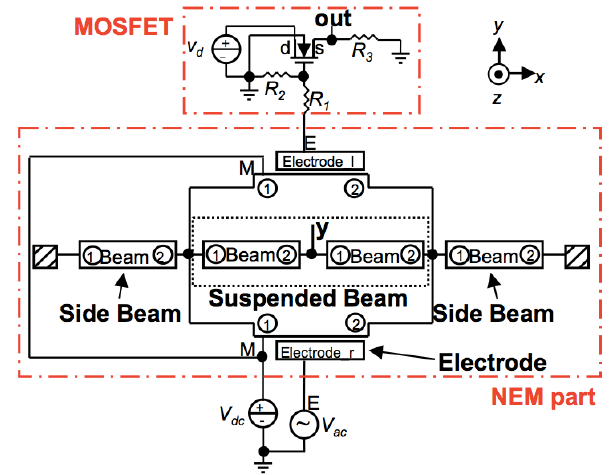
The hybrid circuit model of the in-plane resonant suspended